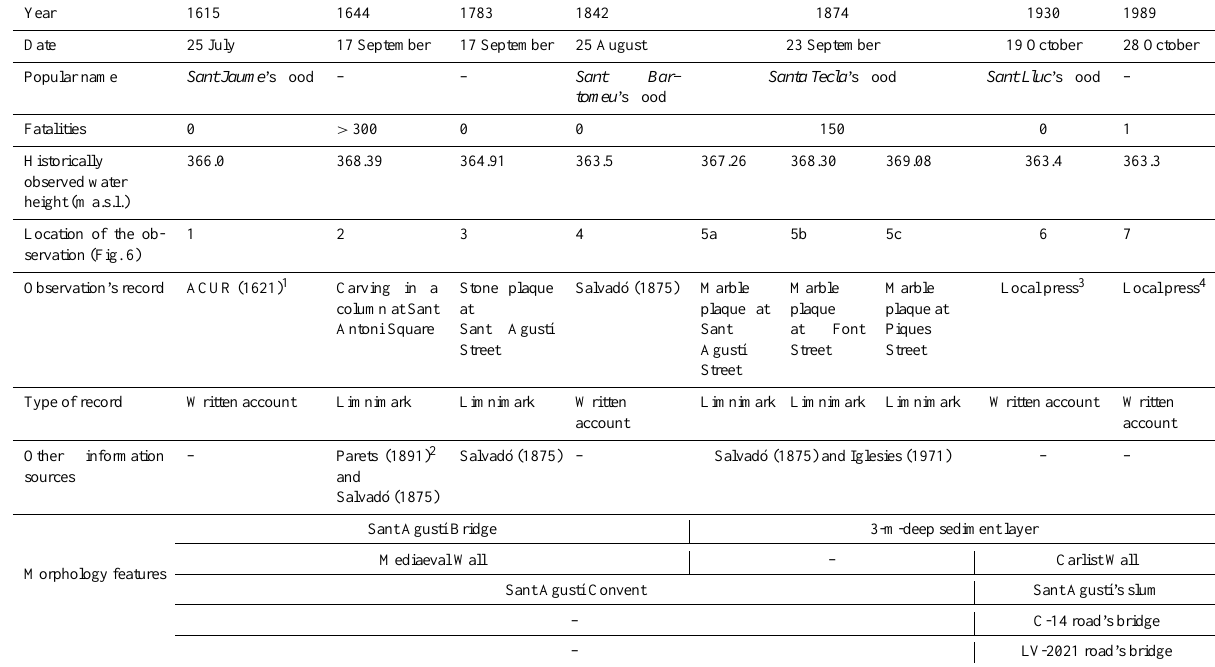
Table 1. Summary of the information about the seven studied floods, their nine historically observed water height records, and the major morphology features present at the time of each